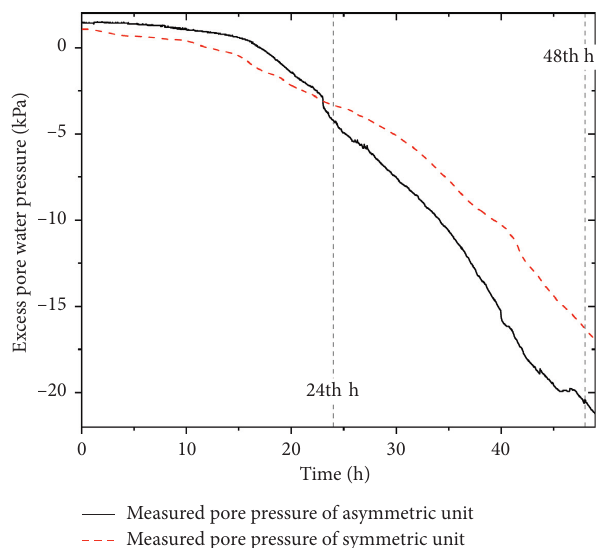
Figure 8: Picture of electroosmotic excess pore water